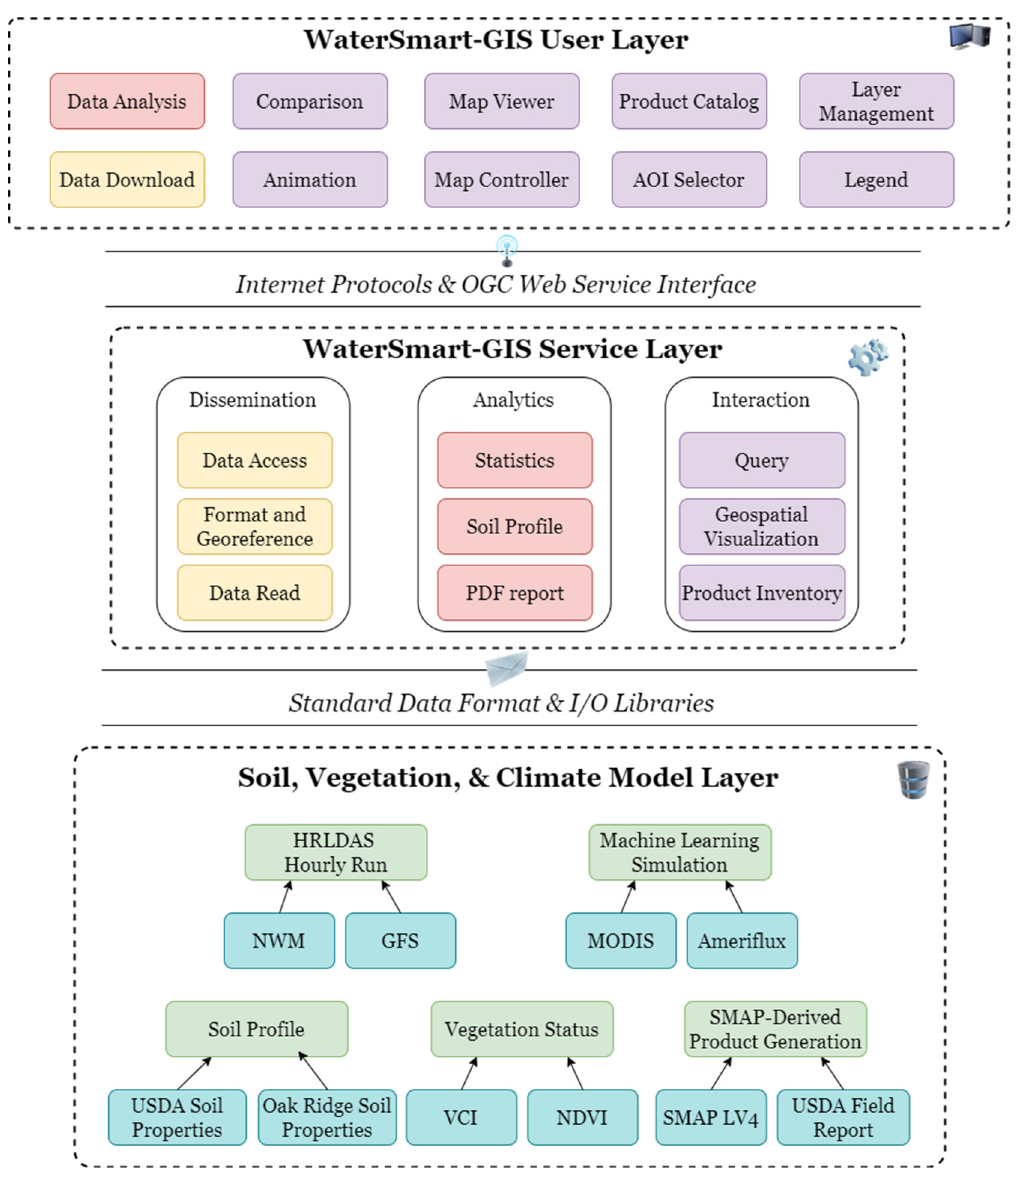
Figure 1. WaterSmart-GIS architect design.